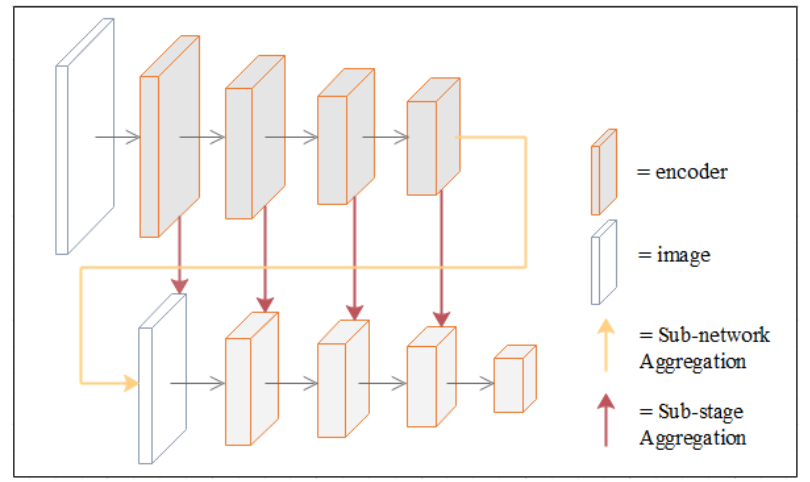
Figure 7. Schematic diagram of deep feature aggregation.